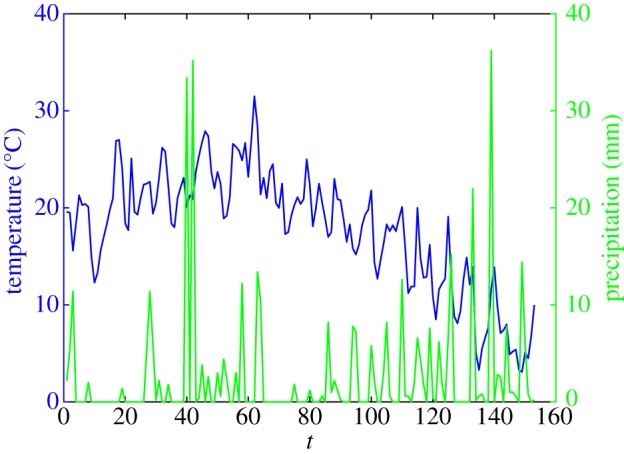
Weather variations from June to October in 2006 in the GTA.